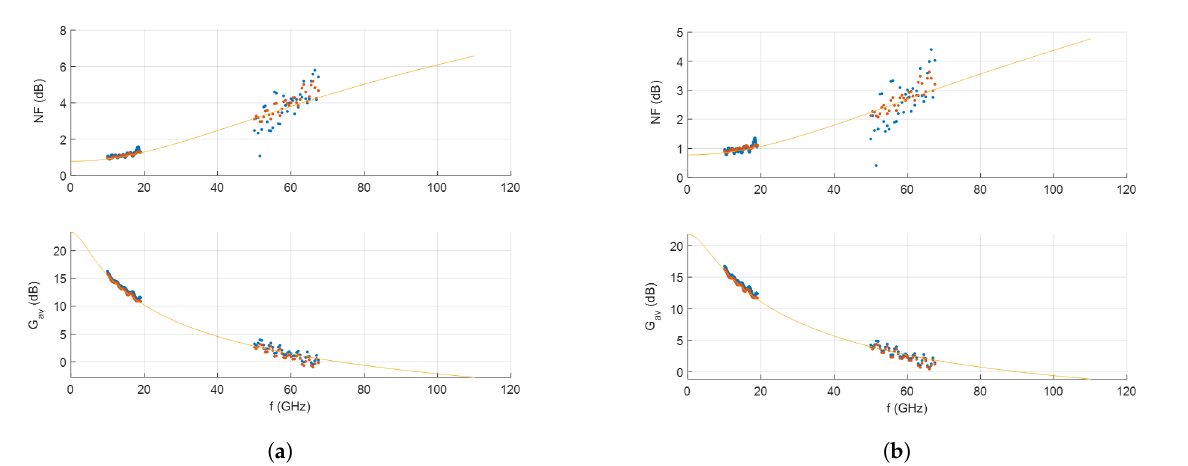
Figure 8. Noise figure and associated gain resulting from noise temperature extractions for 4x050 devices at V DS = 5 V. Points represent the measurement-fitting comparison on the actual source terminations seen by the DUT. Continuous lines represent the modeled values on standard terminations: ( a ) D01GH, I D = 61.2 mA. ( b ) D006GH, I D = 73.2